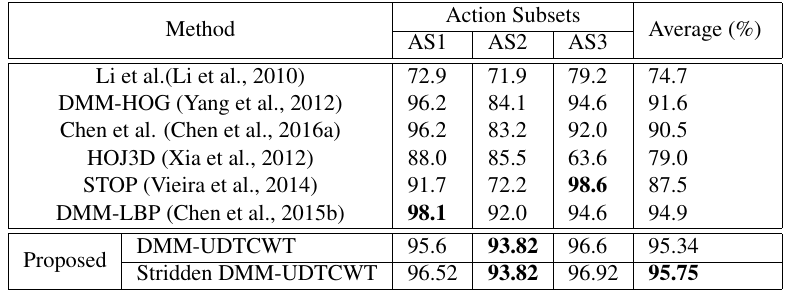
Table 1. Average recognition accuracies (%) under Cross Subject tests on fixed subsets on MSR Action 3D dataset. 100.0% 12